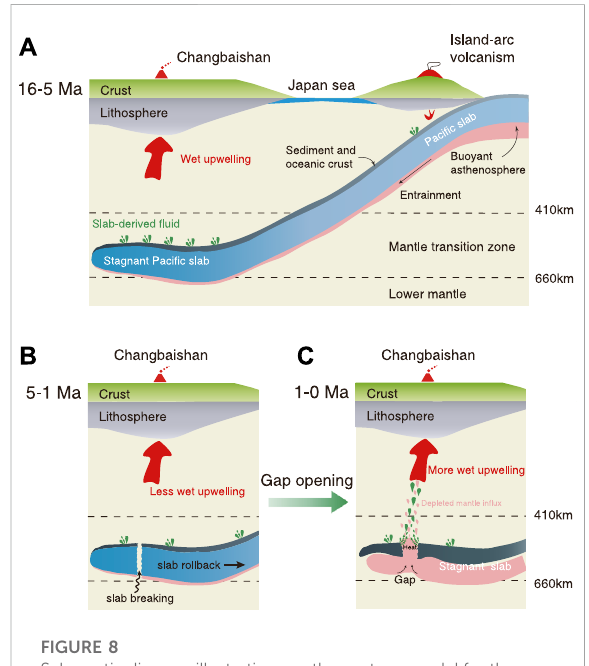
FIGURE 8 Schematic diagram illustrating our three-stage model for the genesis of the CBS volcanoes. (A) From 16 to 5 Ma. The Paci fi c Plate penetrates the mantle and stagnates in the mantle transition zone beneath the CBS volcanic region. Sub-slab asthenosphere is entrained downward. The buoyant and hydrous upwelling, induced by the dehydration of the stagnant Western Paci fi c slab, feeds the CBS volcanoes. (B) At about 5 Ma, slab breaking occurred, which caused partial removal of the slab and hence gradually weakened the in fl uence of fl uid. (C) From 1 Ma to present. A gap was created in the stagnant slab. The hot sub-slab asthenosphere melts went through the gap and heated the surrounding sediment and oceanic crust, providing fl uid-rich and depleted mantle in fl ux to the wet